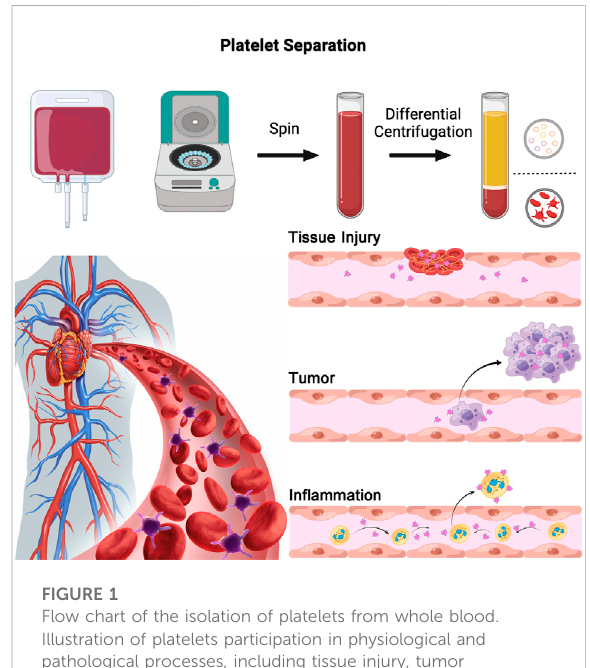
FIGURE 1 Flow chart of the isolation of platelets from whole blood. Illustration of platelets participation in physiological and pathological processes, including tissue injury, tumor development and metastasis, and in fl